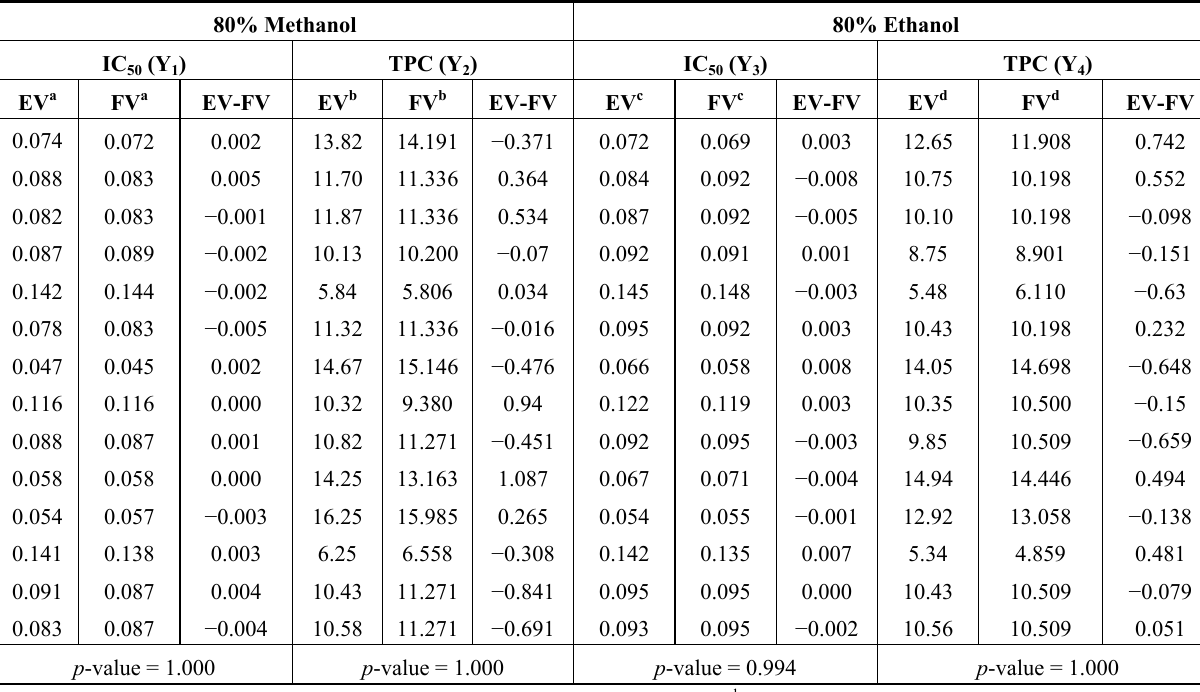
Table 4. Experimental and fitted value of responses and p -value of validation (two-sample t-test). 80% Methanol 80%